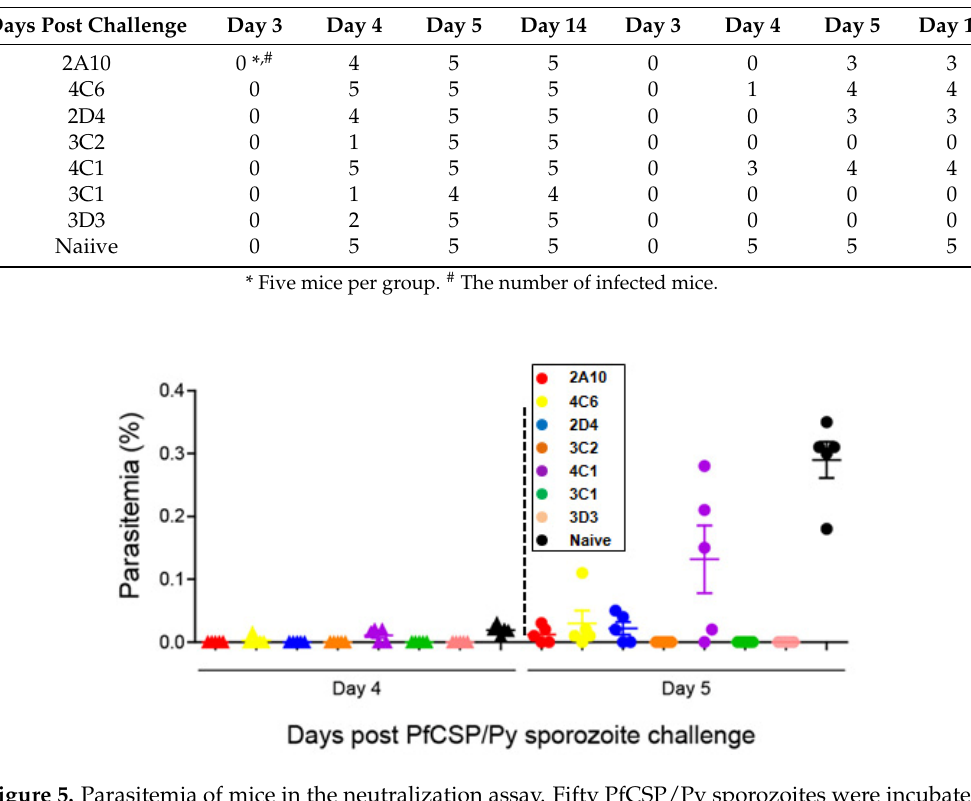
Figure 5. Parasitemia of mice in the neutralization assay. Fifty PfCSP/Py sporozoites were incubated with 50 µ g mAbs followed by i.v. injection into BALB/c mice (five mice per group). Parasitemia were counted by Giemsa stains of mouse tail blood followed by microscopy. Data are parasitemia of the mice four and five days post challenge. Naive mice were i.v. injected with 50 PfCSP/Py sporozoites as positive